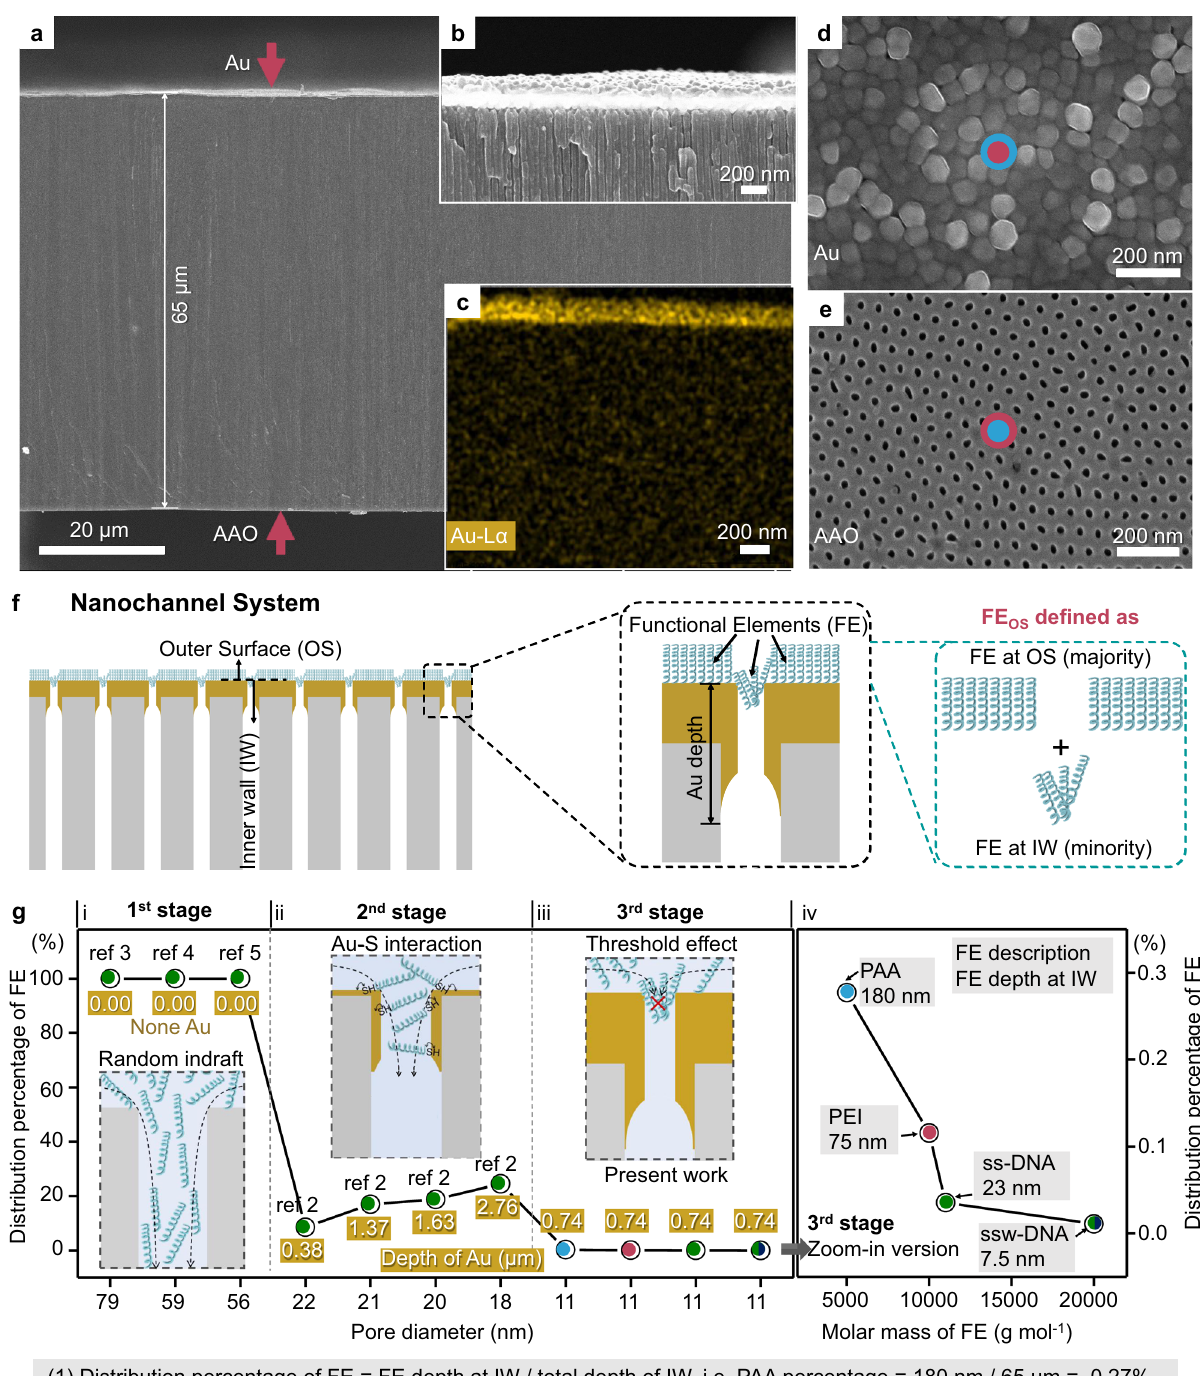
(1) Distribution percentage of FE = FE depth at IW / total depth of IW, i.e. PAA percentage = 180 nm / 65 μm =